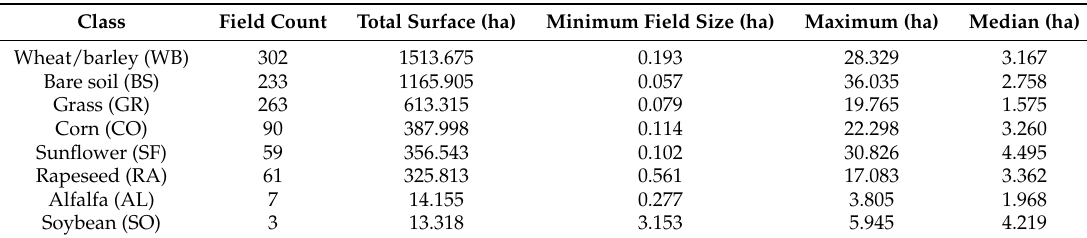
Table 1. Number of fields and associated surfaces for each class in the reference data.